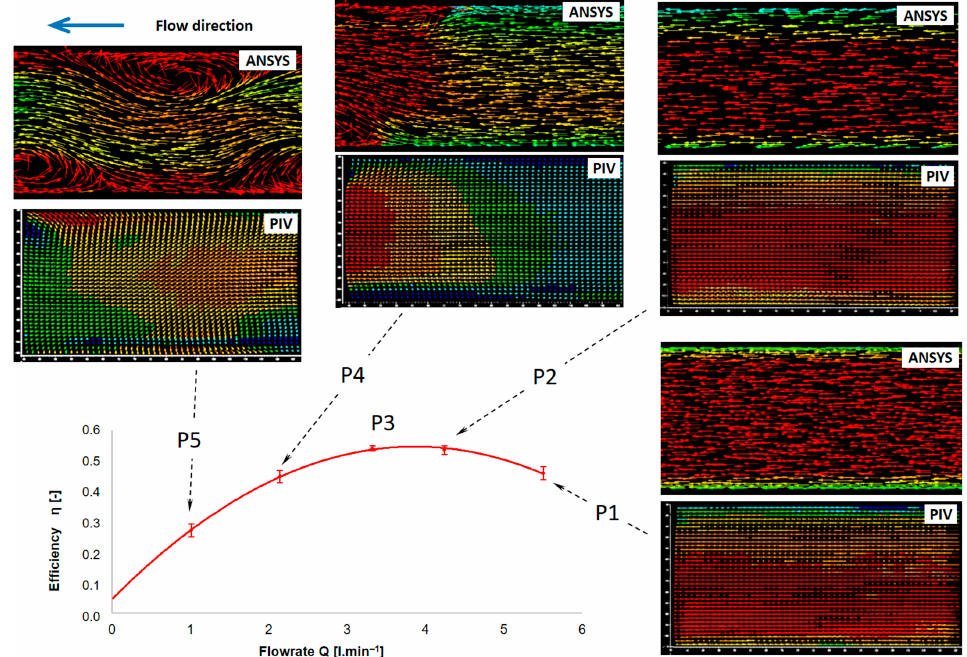
Figure 7. Comparison of vector maps from the numeric model (Ansys, setting 1) and the experiment (PIV).